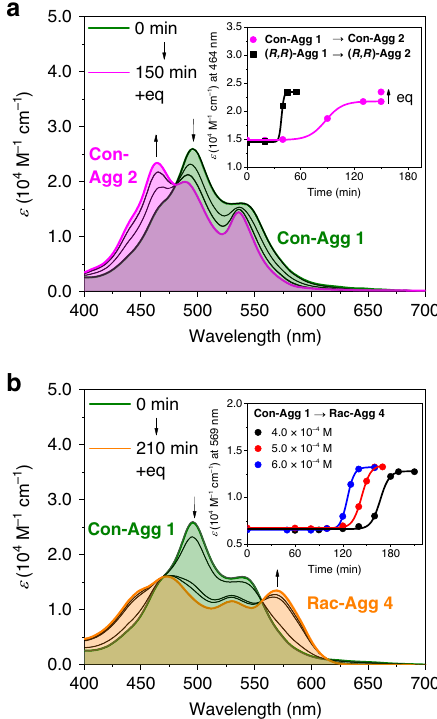
Fig. 4 Kinetic analyses of conglomerate and racemic supramolecular polymer formation. a UV/vis absorption spectra for the transformations of a Con-Agg 1 → Con-Agg 2 ( c T = 3.0 × 10 − 4 M, sonication at 293 – 298K) and b Con-Agg 1 → Rac-Agg 4 ( c T = 4.0 × 10 − 4 M, sonication at 308 K) in MCH/Tol (5:4, v / v ) depending on the sonication period. Inset of a : Comparison of the ε values at λ = 464 nm of the ultrasound-induced transformations Con-Agg 1 → Con-Agg 2 with those of the transformation of ( R,R )-Agg 1 → ( R,R )-Agg 2 ( c T = 3.0 × 10 − 4 M). Inset of b : Plot of the time-dependent ε values at λ = 569nm at different concentrations for the ultrasound-induced transformation of Con-Agg 1 → Rac-Agg 4 . “ Eq ” denotes equilibration achieved by letting the solution stand at room temperature after complete transformation. Lines are set to guide the